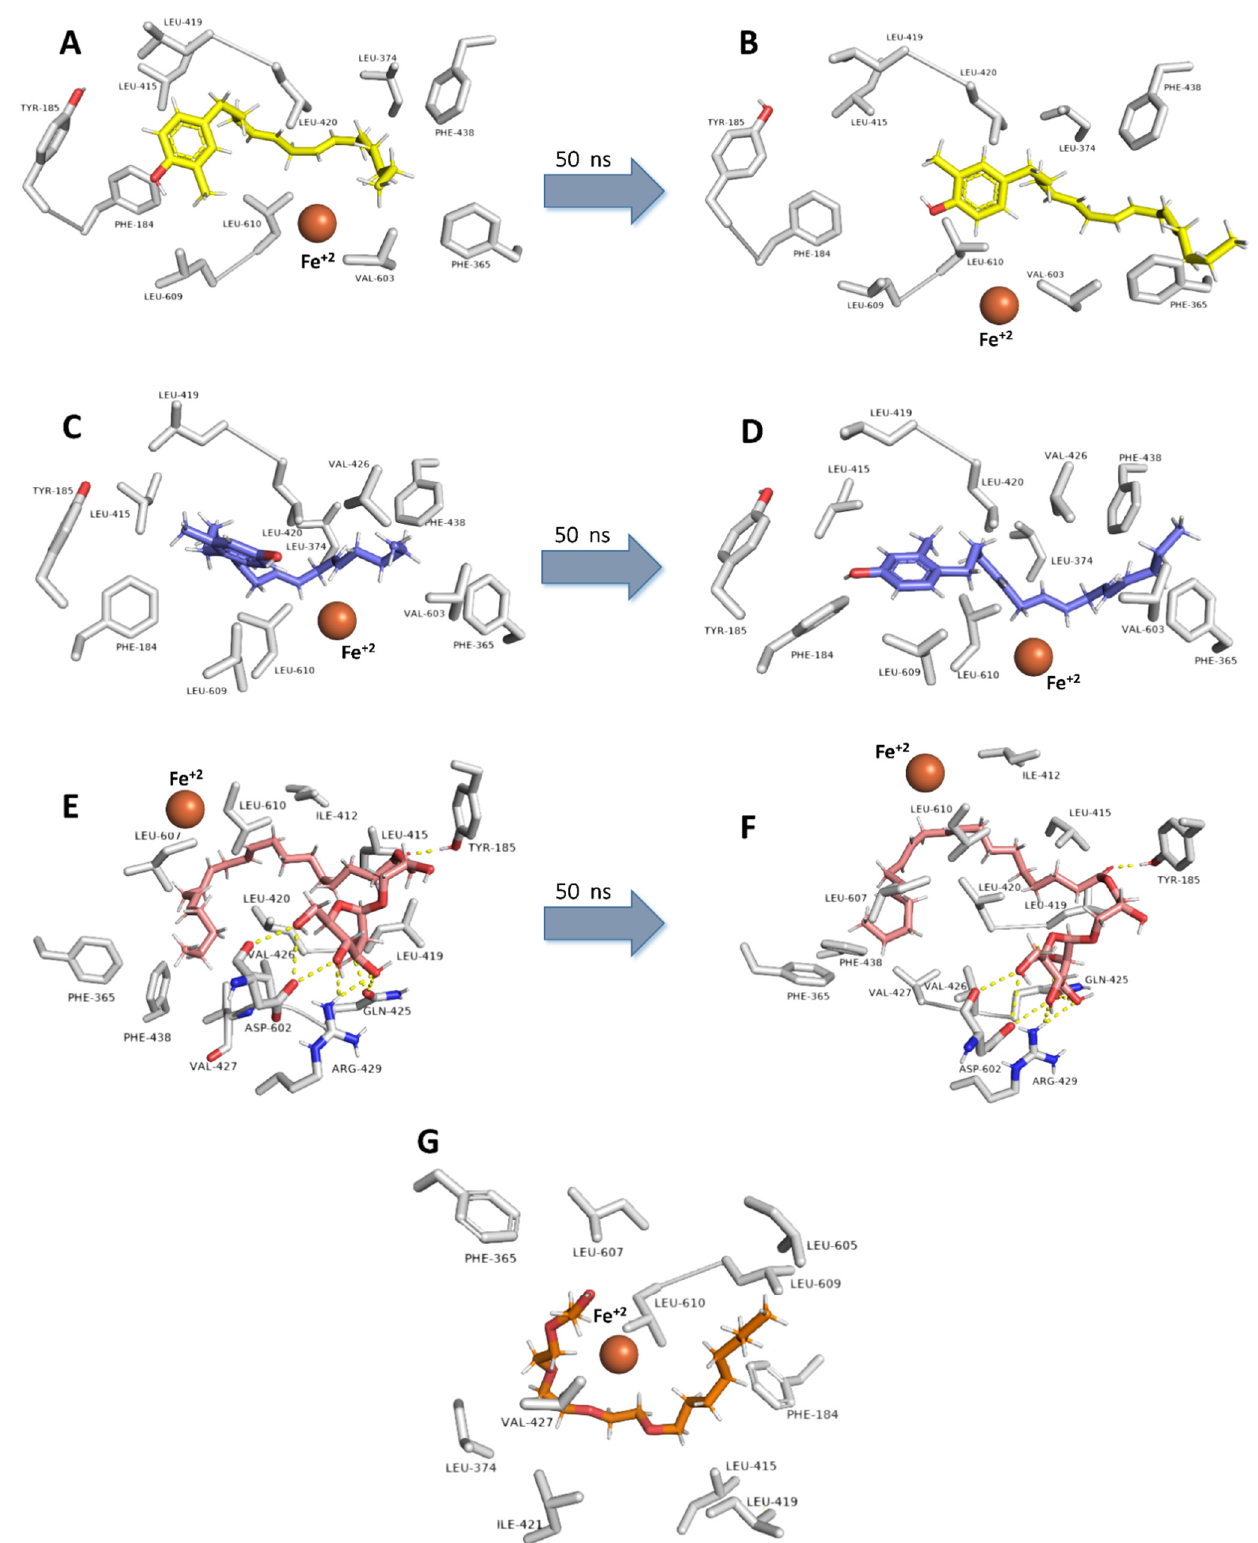
Figure 6. Binding modes of compounds 12 , 13 , and 19 inside 15-LOX’s active site. ( A , C , E ) Their binding modes upon docking. ( B , D , F ) Their binding modes over 50 ns MDS. ( G ) Binding mode of the co-crystalized ligands AA.